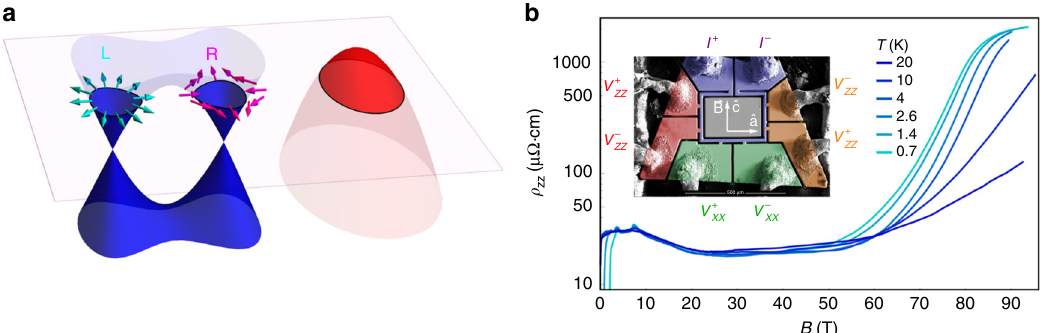
Fig. 1 Weyl fermions and quantum limit transport in TaAs. a the Weyl semimetal TaAs contains three types of charge carriers: trivial holes (red), and two sets of electron-like Weyl fermions, designated W1 and W2, one of which is shown here in blue. The holes are of a single non-chiral carrier type, and contribute a non-Weyl background signature to experiments. The Weyl electrons are separated into distinct right and left-handed chiralities: arrows indicate the winding of the pseudospin around each Fermi surface. b Resistivity of TaAs for J jj B jj c from 0.7 to 20 K. Quantum oscillations from the Weyl pockets are visible up to 7.5 T, followed by a decrease and then saturation of ρ zz up to 50 T. Above 50 T there is a two order-of-magnitude increase in ρ zz at low temperature, signifying the opening of a gap. The inset shows single-crystal TaAs microstructured using focused-ion-beam (FIB) lithography for both the ρ zz and ρ xx